Question: Is the quantity shown trending increasing or decreasing?
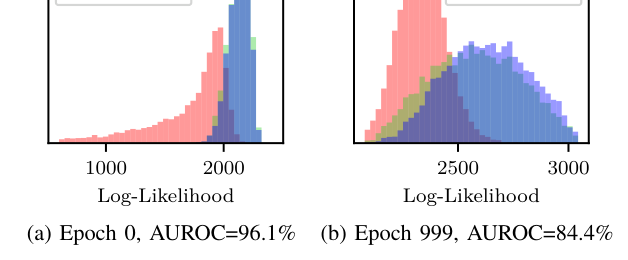
Answer: increasing